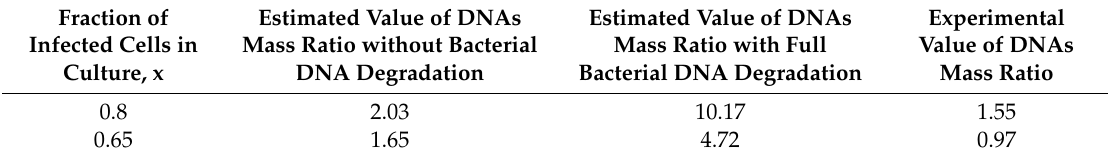
Table 2. Comparison of estimated values of the ration of the phage DNA mass to the bacterial DNA mass at the end of the infection, AU.